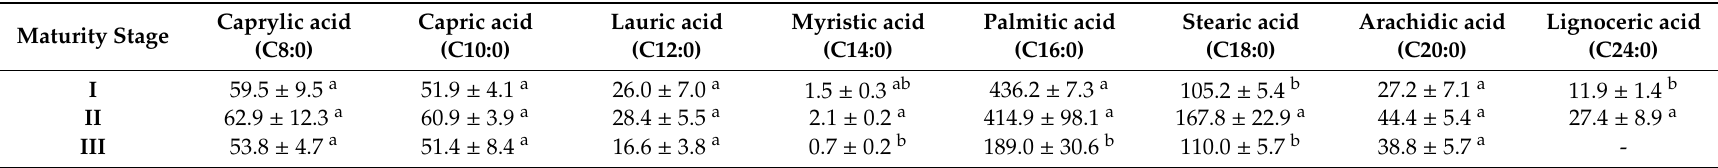
Table 3. Saturated fatty acids (mg / 100 g d.w.) of the three maturity stages of Aloe vera flowers. Stage I: immature; stage II: mature; stage III: mature with stamens exposed to the outside.